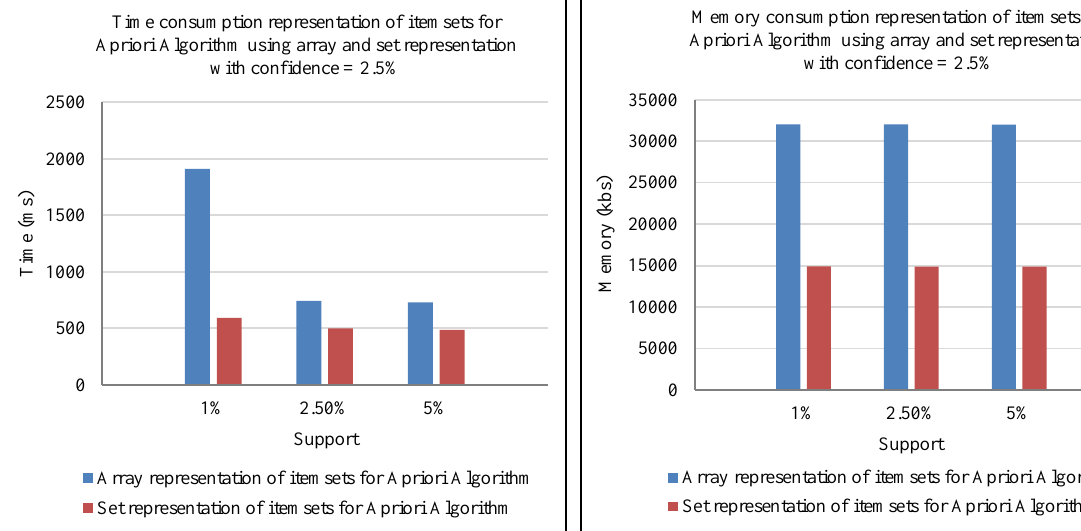
Figure 10. Time and memory consumption of Apriori Algorithm using set and array representation with confidence= 2.5%.